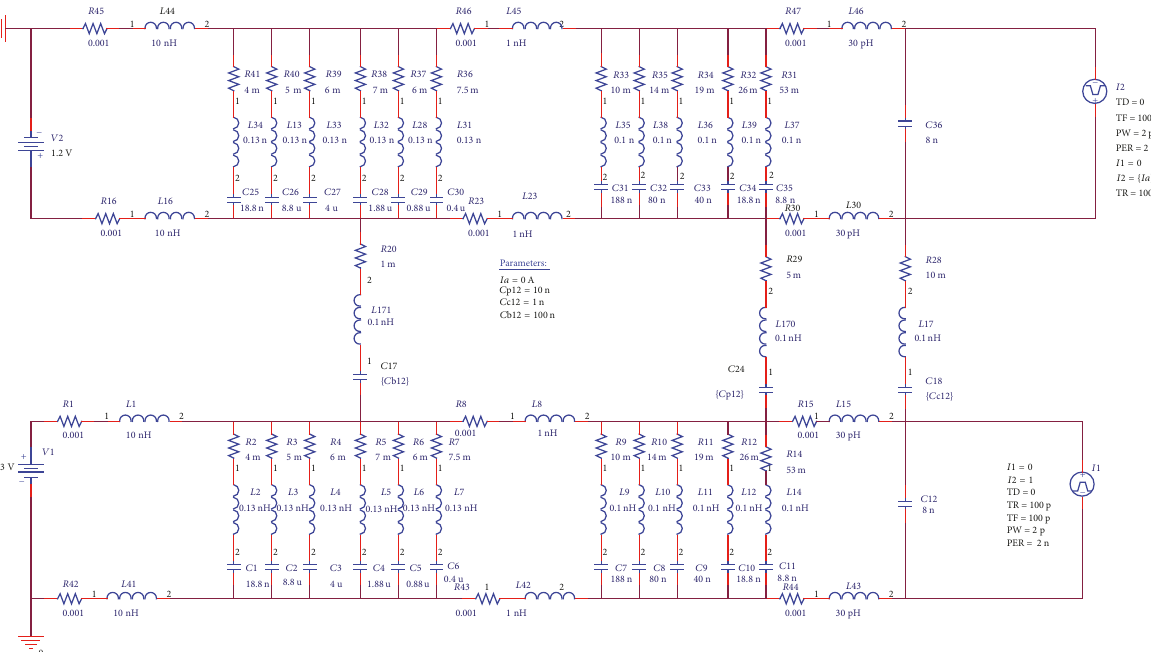
= 1nF, 𝐶 = 10nF, and 𝐶 = 1nF. (a) 𝐼 2 = 1A. (b) 𝐼 2 = 0A. b 12 p 12 c 12